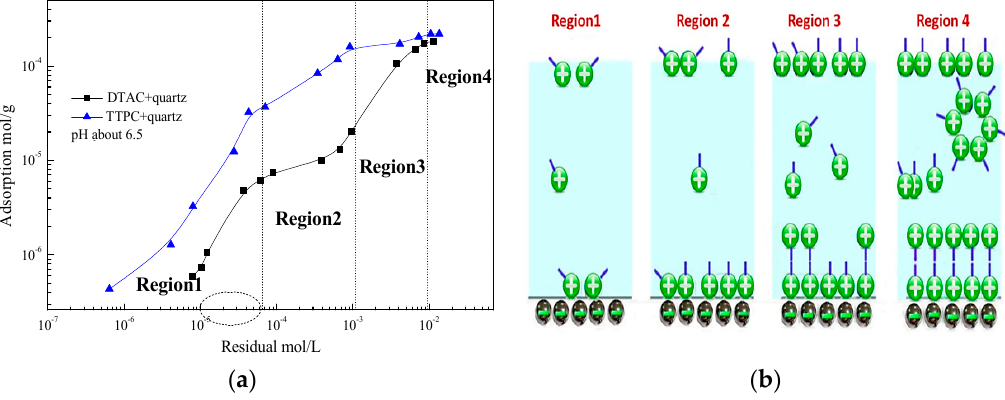
Figure 9. ( a ) Adsorption isotherm of TTPC and DTAC on quartz surface, and ( b ) the proposed adsorption models of TTPC and DTAC at the quartz/water interface for different regions in the adsorption isotherms of ( a ).